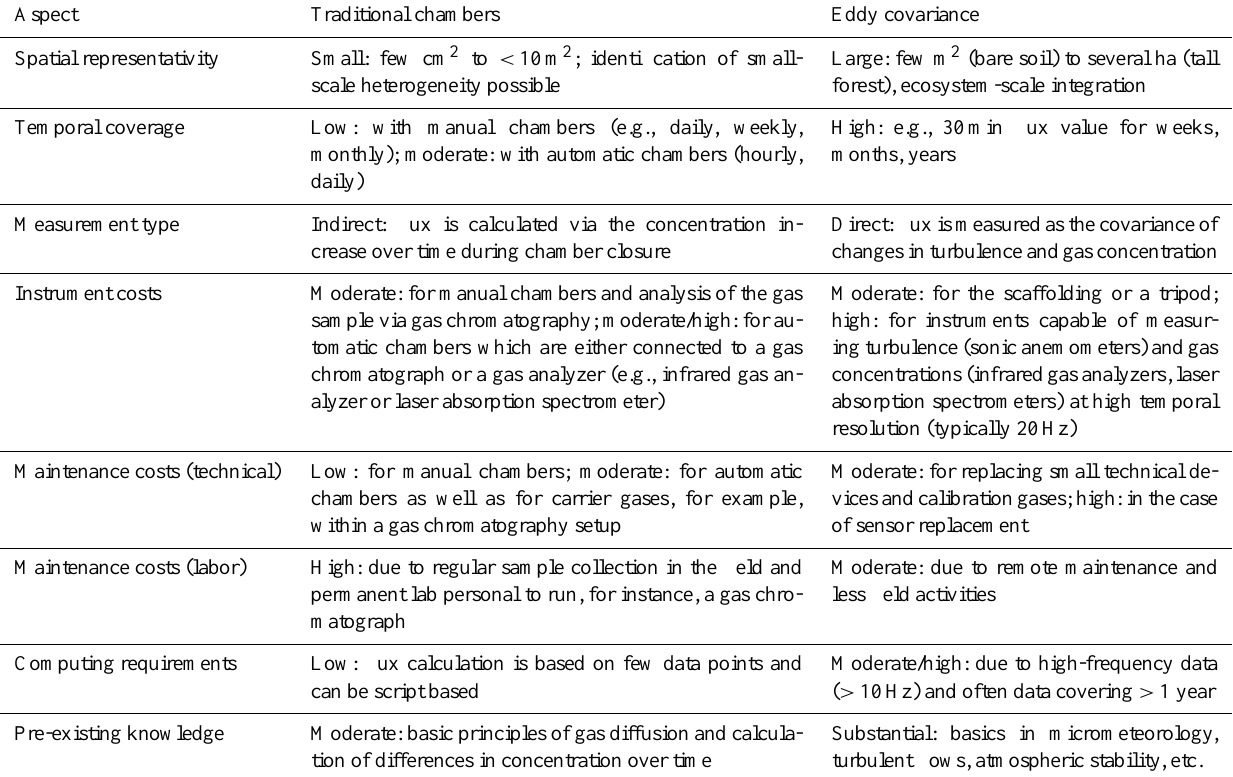
Table 1. Overview of the major characteristics of traditional chamber systems and the eddy covariance method to measure trace gas fluxes. Aspect Traditional chambers Eddy covariance Spatial representativity Small: few cm 2 to < 10m 2 ; identification of small- Large: few m 2 (bare soil) to several ha (tall scale heterogeneity possible forest), ecosystem-scale integration High: e.g., 30min flux value for weeks, Temporal coverage Low: with manual chambers (e.g., daily, weekly, months, daily)